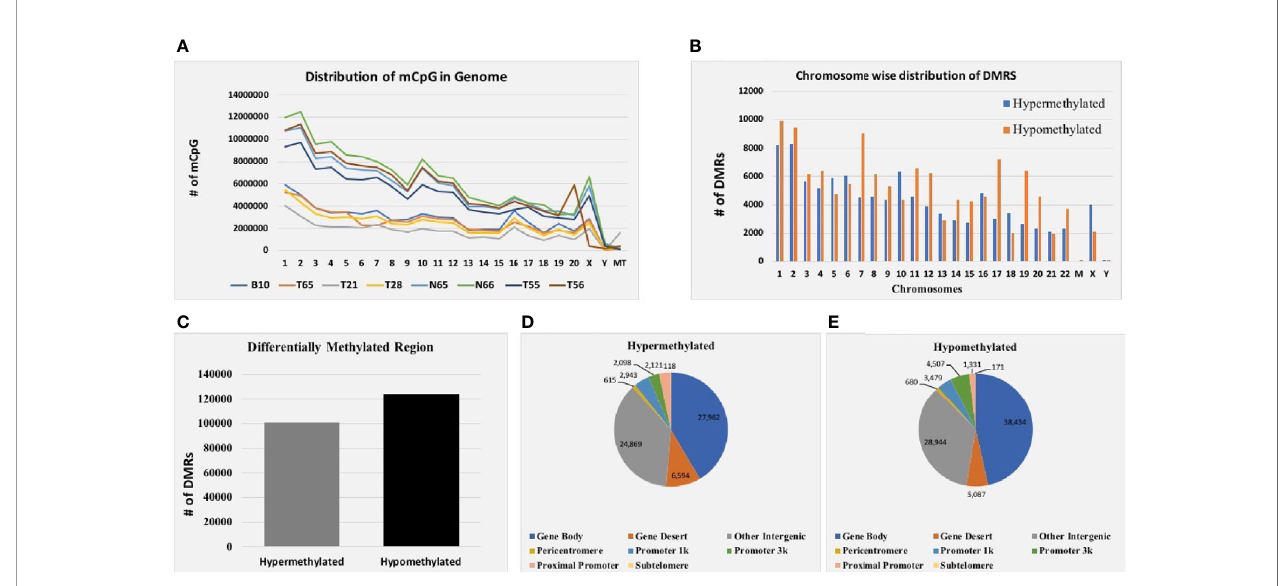
FIGURE 2 | MeDIP-seq results. (A) Distribution of methylated CpG in each chromosome of eight EOC tissue samples. (B) Total distribution of hypo- and hypermethylated differentially methylated regions (DMRs) at each chromosome of eight tissue samples. (C) Total hyper- and hypomethylated DMRs obtained from eight EOC tissue samples. (D) Distribution of hypermethylated DMRs in different genomic regions. (E) Distribution of hypomethylated DMRs in different genomic regions of eight EOC tissue